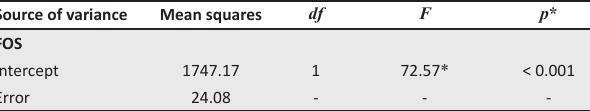
FIGURE 1: Learner’s response to the goal setting